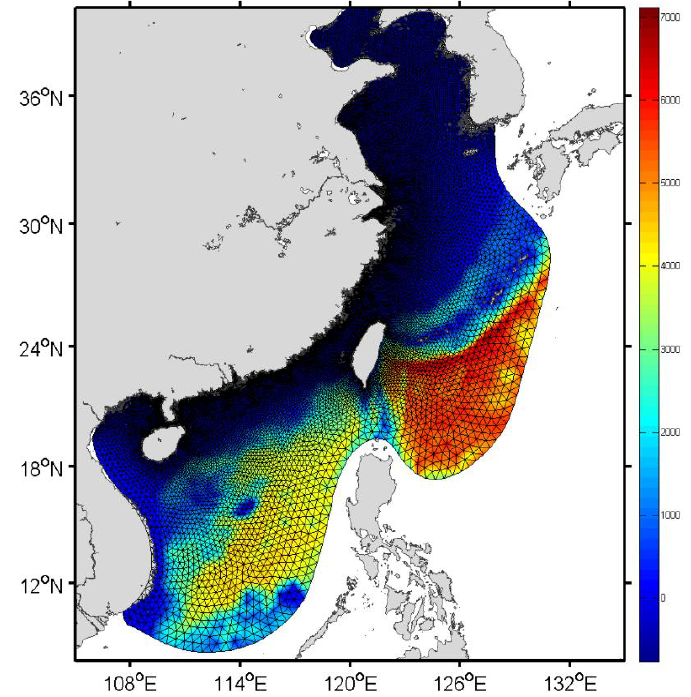
Figure 2. Mesh with 29,235 nodes in the waters off the eastern and southern coast of China. The fine grid resolution is around 2 km along the Taiwan Strait coast.